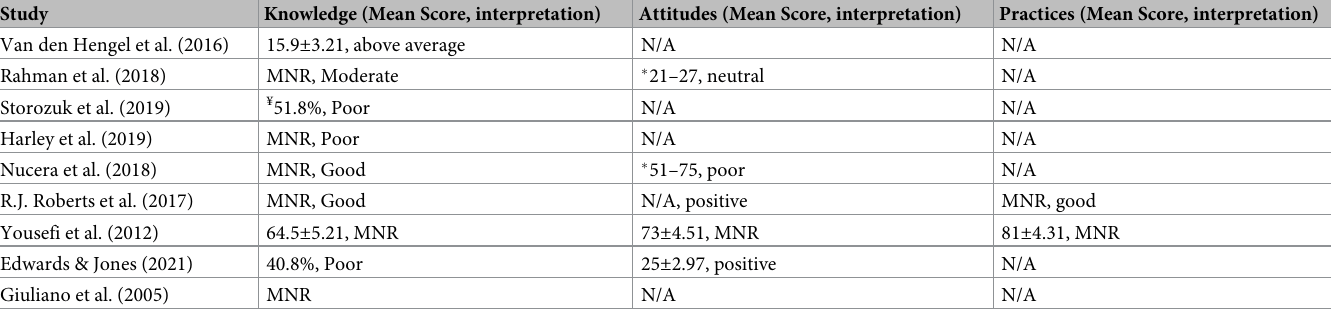
Table 3. Knowledge, attitudes, and practices related to sepsis assessment and management.